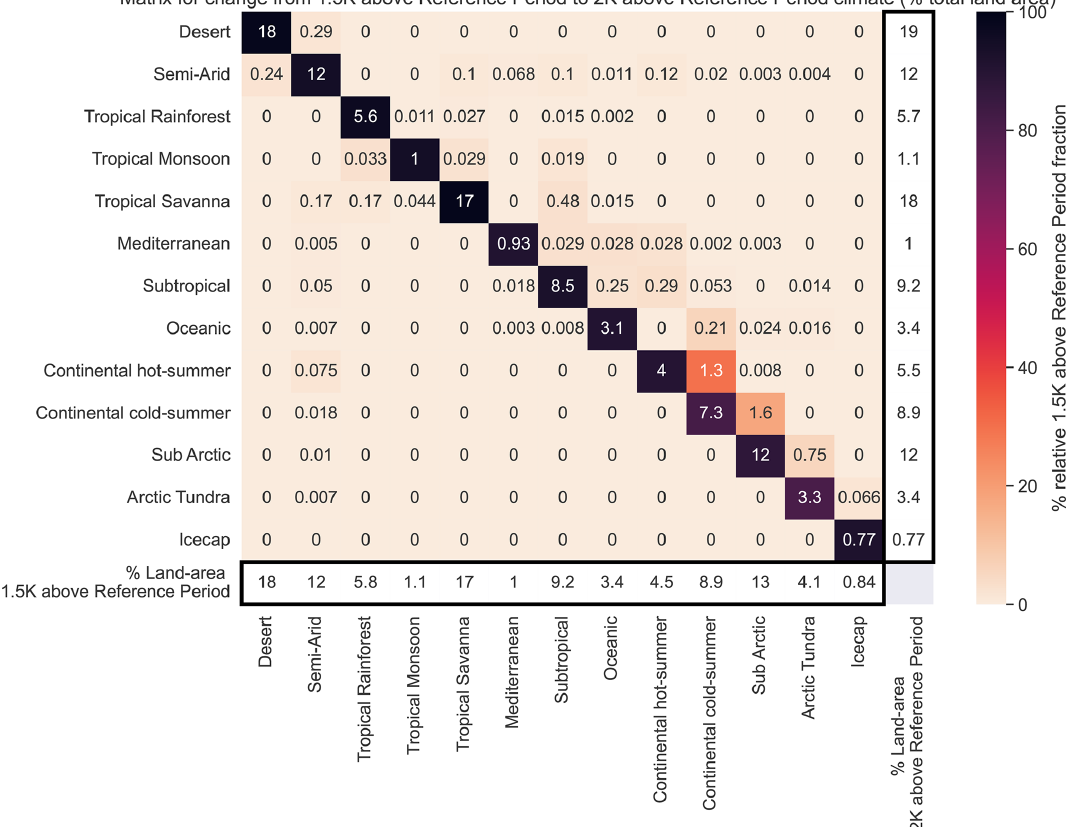
Figure C1. Land area bioclimate classification change between 1.5 and 2K of global warming.